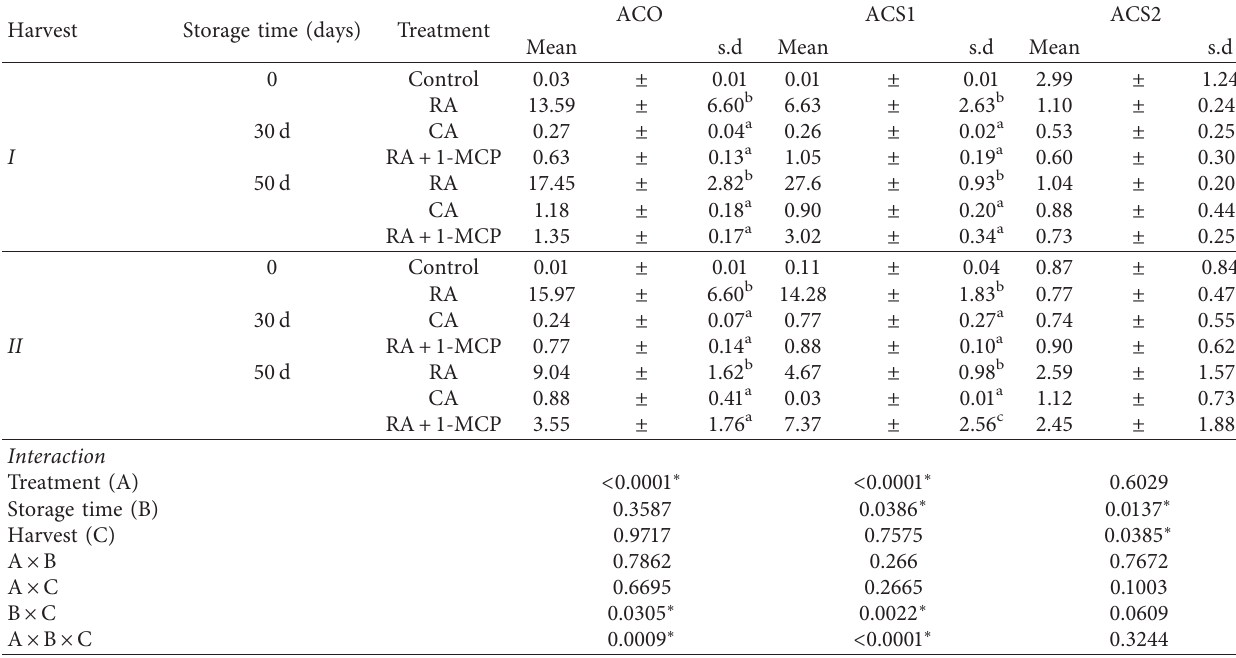
Table 5: Gene expression analysis of PamACO , PamACS1 , and PamACS2 transcript in avocado “Edranol” under different storage conditions for 30 and 50 days at 5 ° C. Fruit was harvested at two maturity stages.